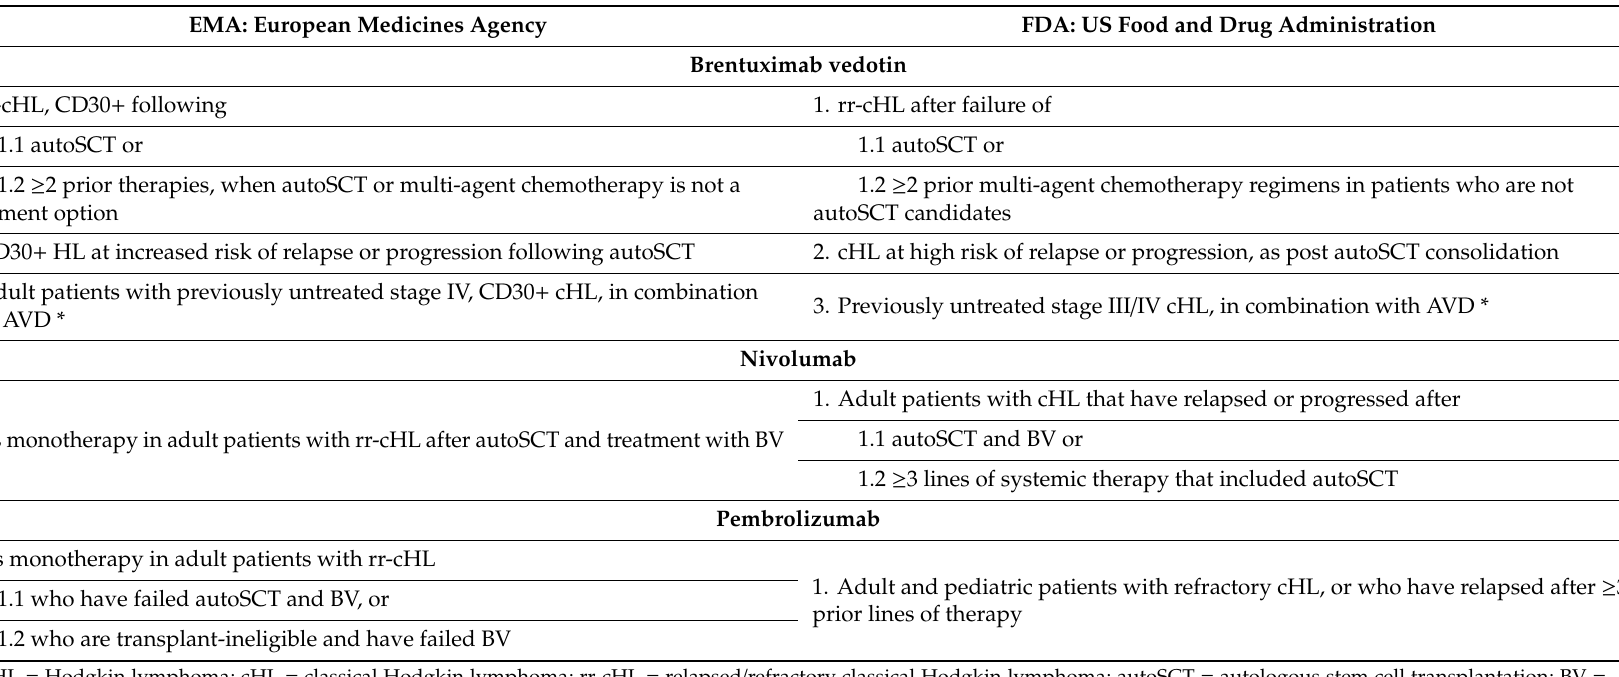
Table 1. Approved indications of brentuximab vedotin, nivolumab, and pembrolizumab according to the European Medicines Agency (EMA) and the US Food and Drug Administration